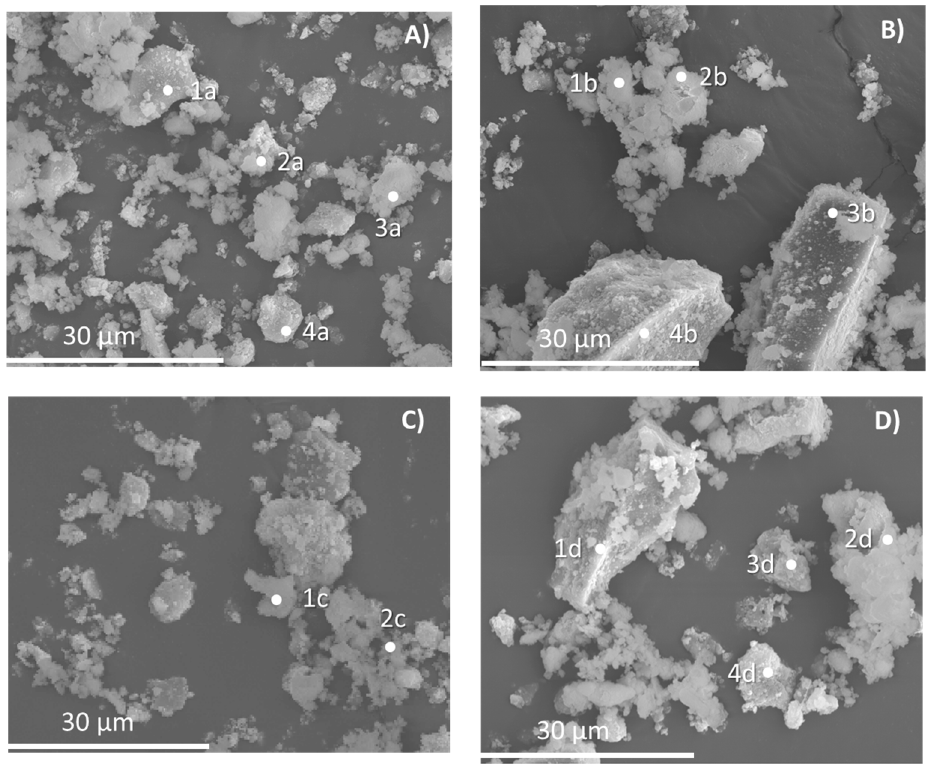
Figure 8. Microphotographs obtained from scanning electron microscopy. ( A ) REF ‐ I, ( B ) M ‐ I, ( C ) M ‐ II and ( D ) M ‐ VI.